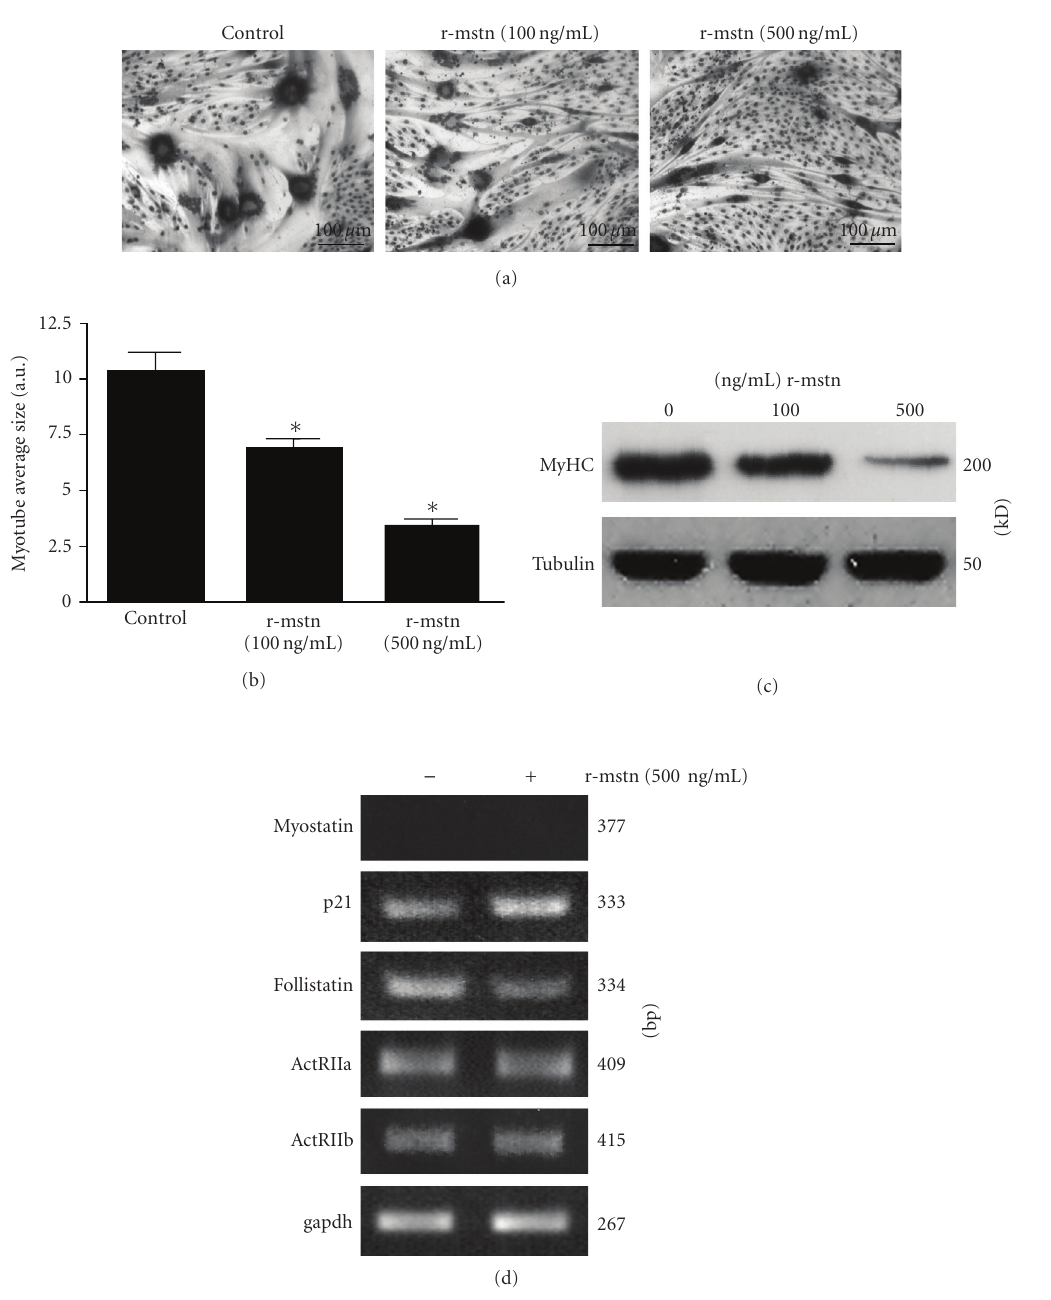
Figure 2: (a) Morphological visualization of L6E9 myotubes, untreated (control, day 5) or treated at day 3 with 100 or 500 ng/mL recombinant myostatin (r-mstn) up to 48 hours, as depicted by phase contrast pictures after Giemsa staining. Bar = 100 μ m. (b) The graph represents the quantification of average size in L6E9 myotubes, treated with 100 or 500 ng/mL r-mstn up to 48 hours as compared to control. ∗ P < . 05 versus control. (c) Immunoblotting shows that MyHC levels are downregulated in L6E9 myotubes exposed to r-mstn (100 or 500ng/mL) up to 48 hours as compared to untreated cells. Tubulin was used as loading control. (d) Semiquantitative RT-PCR analysis was performed to detect the expression levels of myostatin, p21, follistatin, ActRIIa, and ActRIIb in L6E9 myotubes (day 3) treated with r-mstn (500ng/mL) up to 48 hours compared to untreated. Gapdh amplification was performed as loading control.